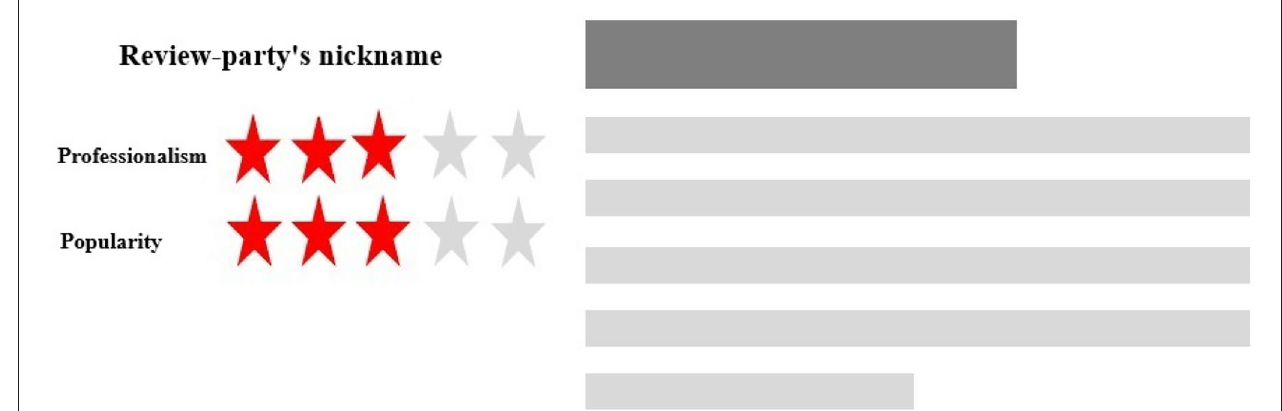
FIGURE 3 | Sample stimulus material for a review.